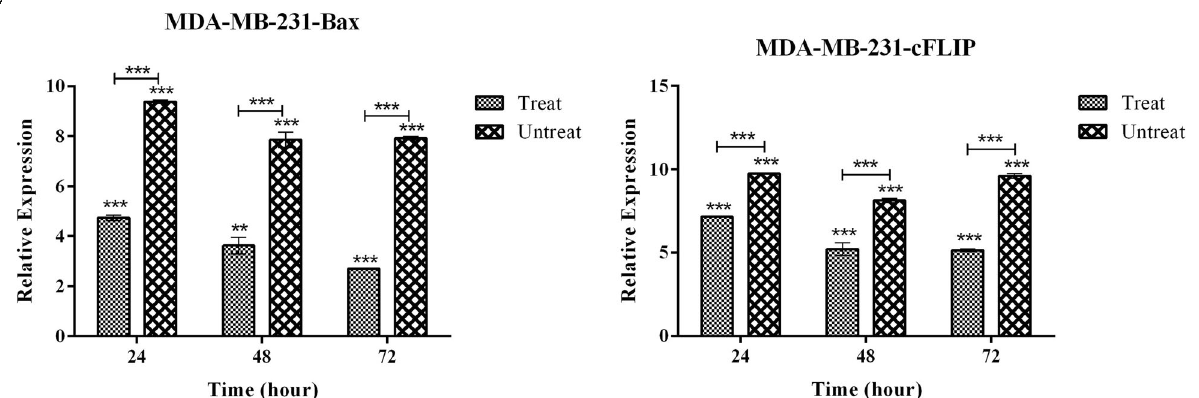
Fig. 3 Relative expression of Bax and c-FLIP in MDA-MB-231 breast cancer cells treated by Prunus armeniaca . Expression levels of the genes were evaluated by qPCR and compared to untreat and control cells by ΔΔ Ct method. ***. Shows significant at the 0.001 level. Error bars show ±